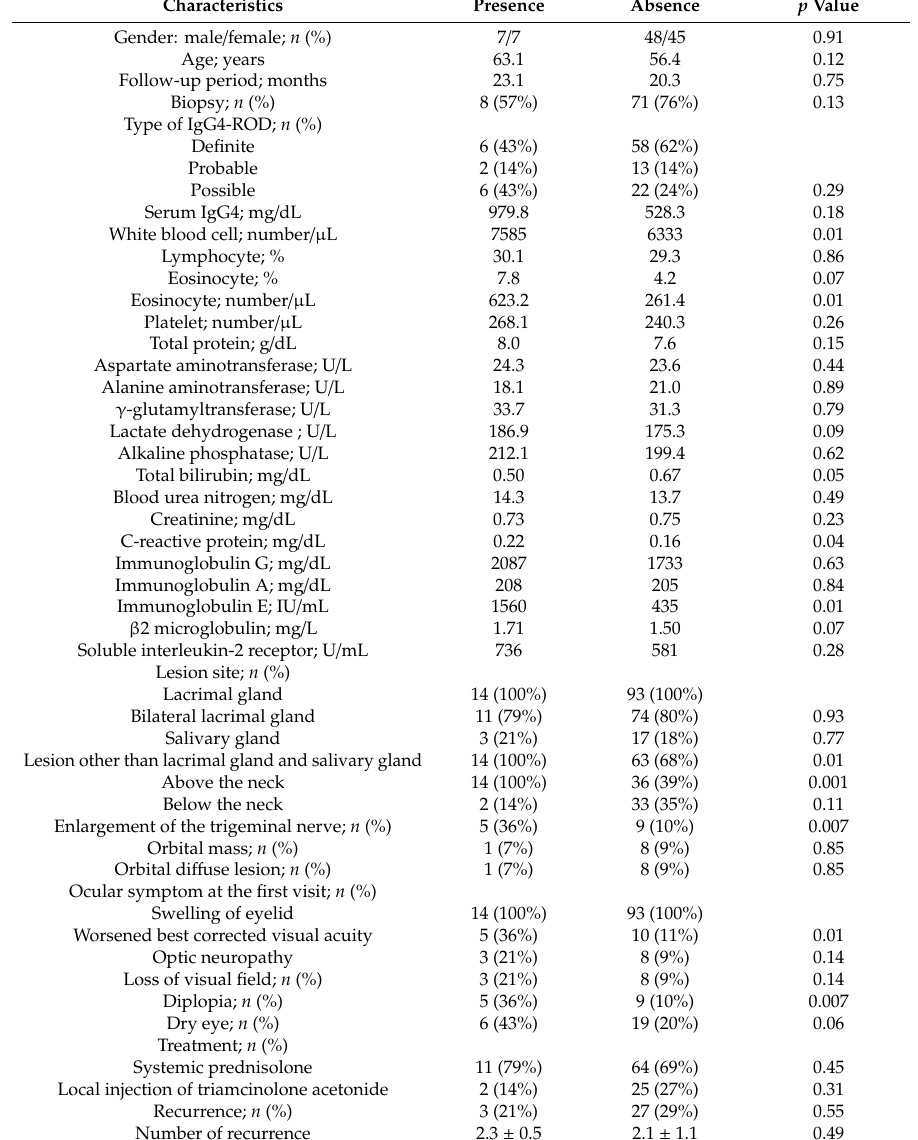
Table 4. Clinical findings in patients with and those without enlargement of extraocular